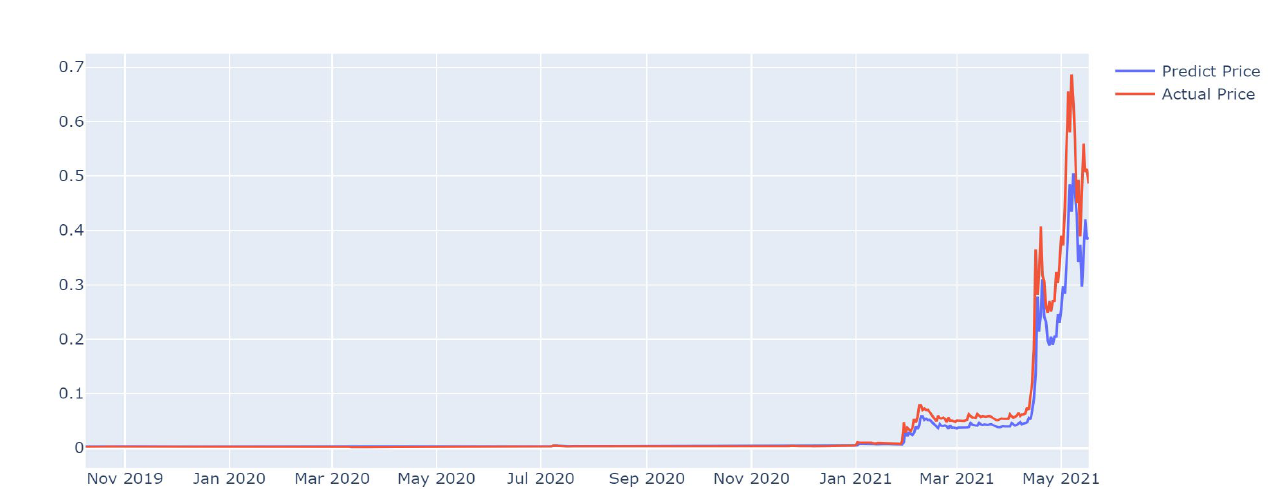
Fig. 8. Price prediction graph when only historical market data is used